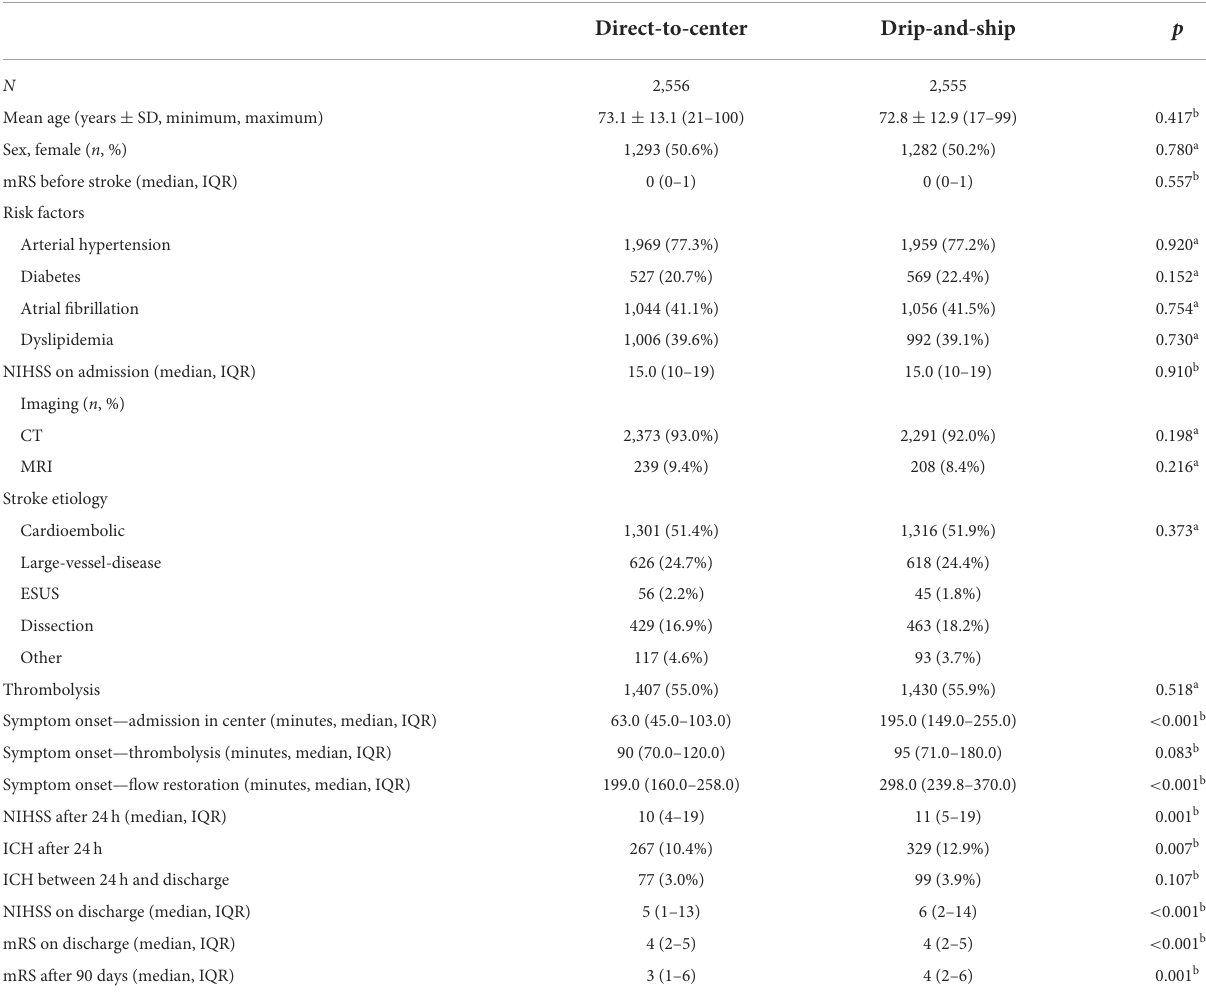
TABLE 2 Results from baseline characteristics, treatment procedures and outcome of direct-to-center and drip-and-ship patients after propensity score matching for age, pre-stroke mRS, NIHSS at admission and thrombolysis. Propensity score matched analysis Direct-to-center